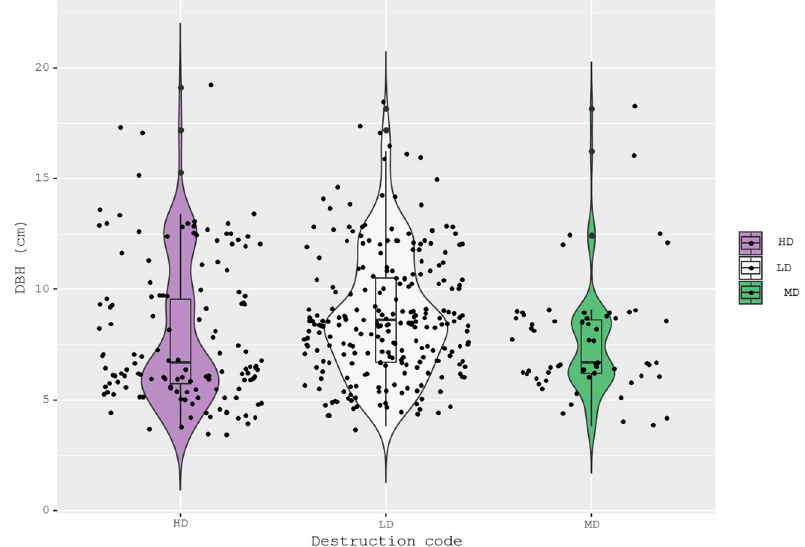
Figure 4. Violin plot (box plot plus kernel density envelop) of tree size (DBH) and disturbance index (by destruction class) distribution in a naturally-regenerated broadleaf forest in the Arasbaran biosphere reserve in Iran ( n = 30). LD = Low Destruction, MD = Medium Destruction, and HD = High Destruction. See Table 2 for description of the destruction class.